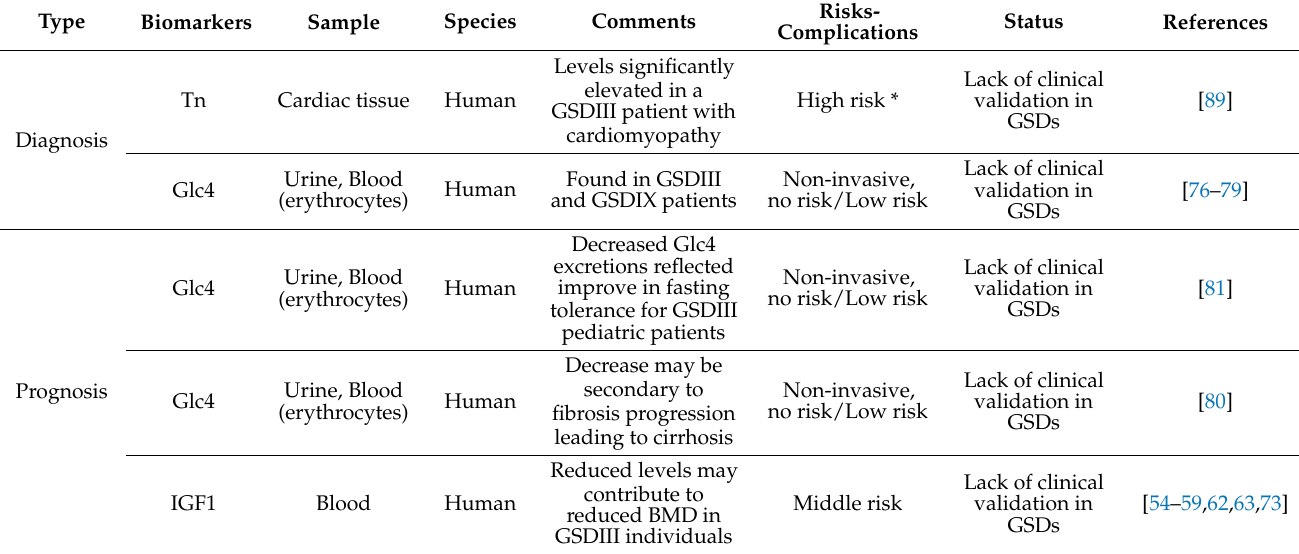
Table 2. Summary of potential biomarkers in other hepatic GSDs (not in Von gierke